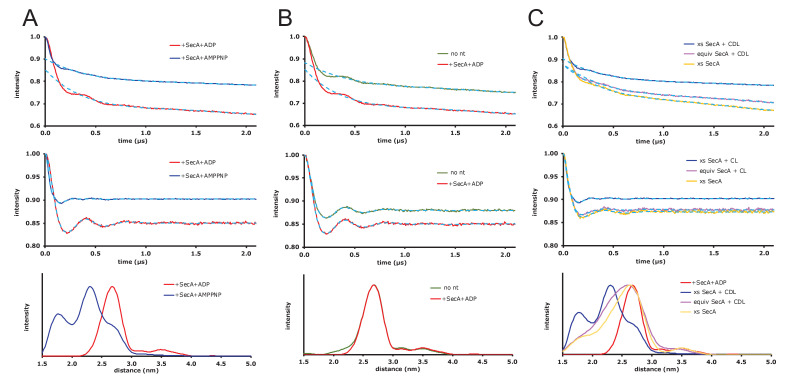
Raw EPR DEER data.(A) Expansion of the DEER results shown in Figure 5 of the main text where spin-labelled SecYEG does not have additional cardiolipin added. Top panel: DEER time traces for spin-labelled SecYEG with 5 × excess SecA and the non-hydrolysable ATP analogue AMPPNP (blue) or ADP (red). The fitted background functions are overlaid in dash cyan and correspond to a fifth order polynomial fit on the data (using DeerAnalysis2016 [Jeschke et al., 2006]) with a 129 ns zerotime and 800 ns cut from the end of the data. Middle panel: Background corrected DEER time traces with the distance distribution fits from Tikhonov Regularization shown by dash cyan. Bottom panel: Distance distributions from the DEER shown above calculated using the default best fit given by DeerAnalysis2016 with Tikhonov Regularization parameters 38 (blue) and 46 (red). The results are presented in the main text. (B) DEER results for spin-labelled SecYEG with SecA and SecA/ADP and additional cardiolipin. Top panel: DEER time traces for spin-labelled SecYEG with 5 × excess SecA alone (green) or with ADP (red). The fitted background functions are overlaid in dash cyan and correspond to a fifth order polynomial fit on the data with a 129 ns zerotime and 800 ns cut from the end of the data. Middle panel: Background corrected DEER time traces with the distance distribution fits from Tikhonov Regularization shown by dash cyan. Bottom panel: Distance distributions from the DEER shown above calculated in DeerAnalysis2016 with Tikhonov Regularization parameters 49 (green) and 46 (red). Taken with the data from A the results show that, for these spin labelling positions, there is no difference in conformation between SecYEG alone, with SecA or with SecA and ADP. (C) DEER results for spin-labelled SecYEG with excess or equivalent SecA, AMPPNP and with or without additional cardiolipin. Top panel: DEER time traces for spin-labelled SecYEG with 5 × excess SecA with additional cardiolipin (blue) and AMPPNP, equivalent SecA and additional cardiolipin (magenta) with AMPPNP and with 5 × excess SecA and no additional cardiolipin but also AMPPNP (mustard). The fitted background functions are overlaid in dash cyan and correspond to a fifth order polynomial fit on the data with a 129 ns zerotime and 800 ns cut from the end of the data. Middle panel: Background corrected DEER time traces with the distance distribution fits from Tikhonov Regularization shown by dash cyan. Bottom panel: Distance distributions from the DEER shown above calculated in DeerAnalysis2016 with Tikhonov Regularization parameters 38 (blue), 188 (magenta) and 140 (mustard). The distributions are compared to the data spin-labelled SecYEG with excess SecA, additional cardiolipin and ADP shown in A (red). These data show that cardiolipin is essential to the gating and that an equivalent ratio of SecA to SecYEG at the concentrations used is not enough to move the population of SecYEG to predominantly open.